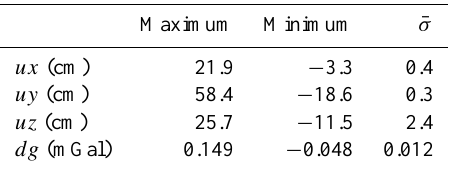
Table 2. Observation changes of the points including the mean stan- dard